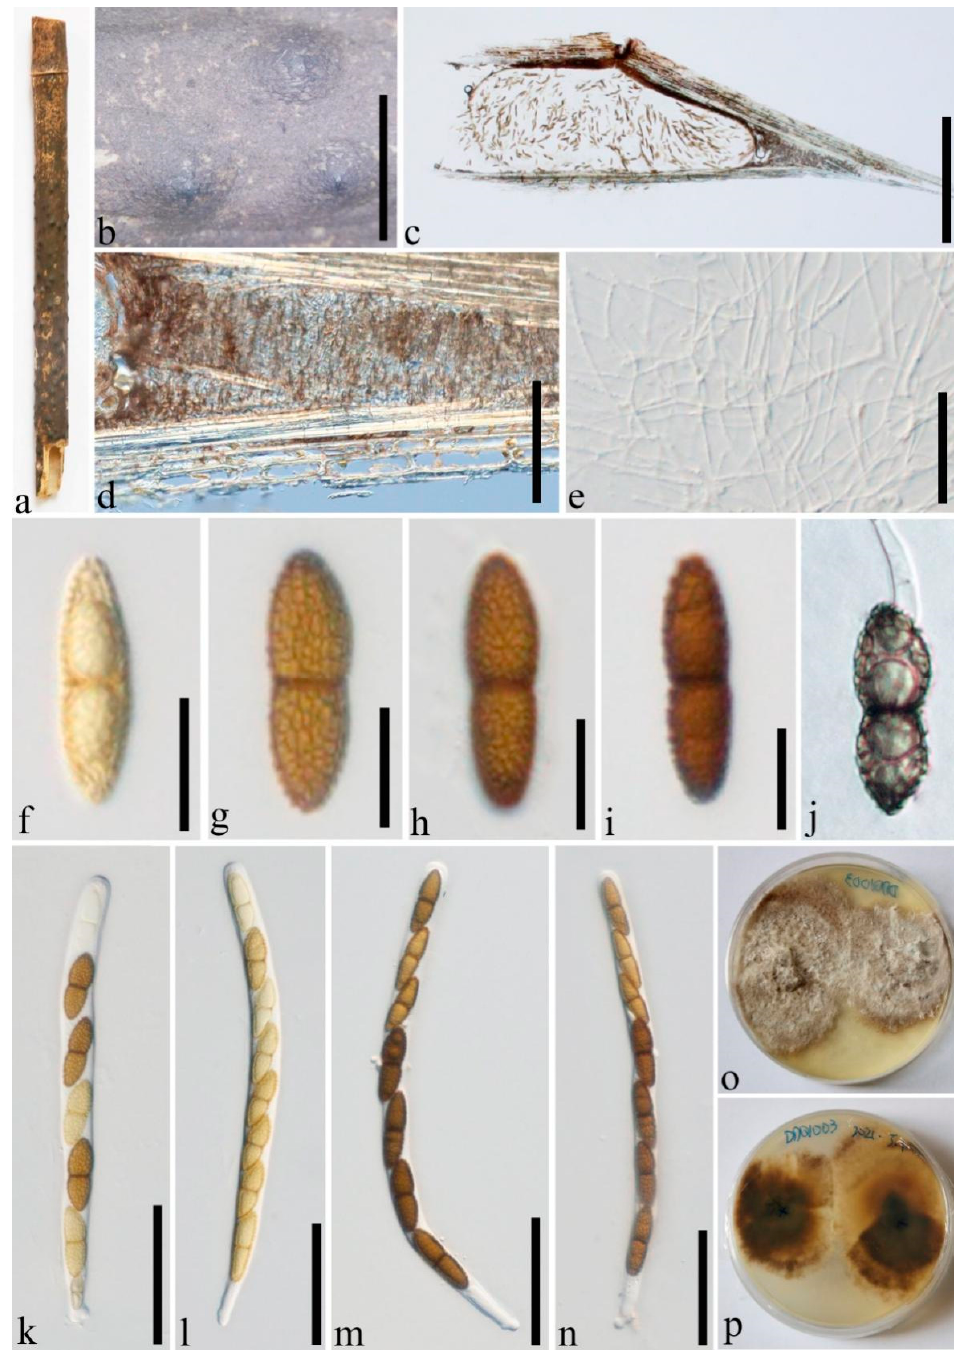
Figure 9. Roussoella scabrispora (GMB1286, new country record). ( a ) Bamboo specimen; ( b ) ascomata on bamboo host; ( c ) vertical section of ascoma; ( d ) peridium; ( e ) pseudoparaphyses; ( f – i ) ascospores; ( j ) germinating ascospore; ( k – n ) asci; ( o , p ) cultures on PDA from above and below. Scale bars: ( b ) = 1 mm, ( c ) = 500 μ m, ( d ) = 100 μ m, ( e ) = 30 μ m, ( f – j ) = 15 μ m, ( k – n ) = 50 μ m. Roussoella sinensis Dai and Wijayaw. sp. nov . Figure 10.